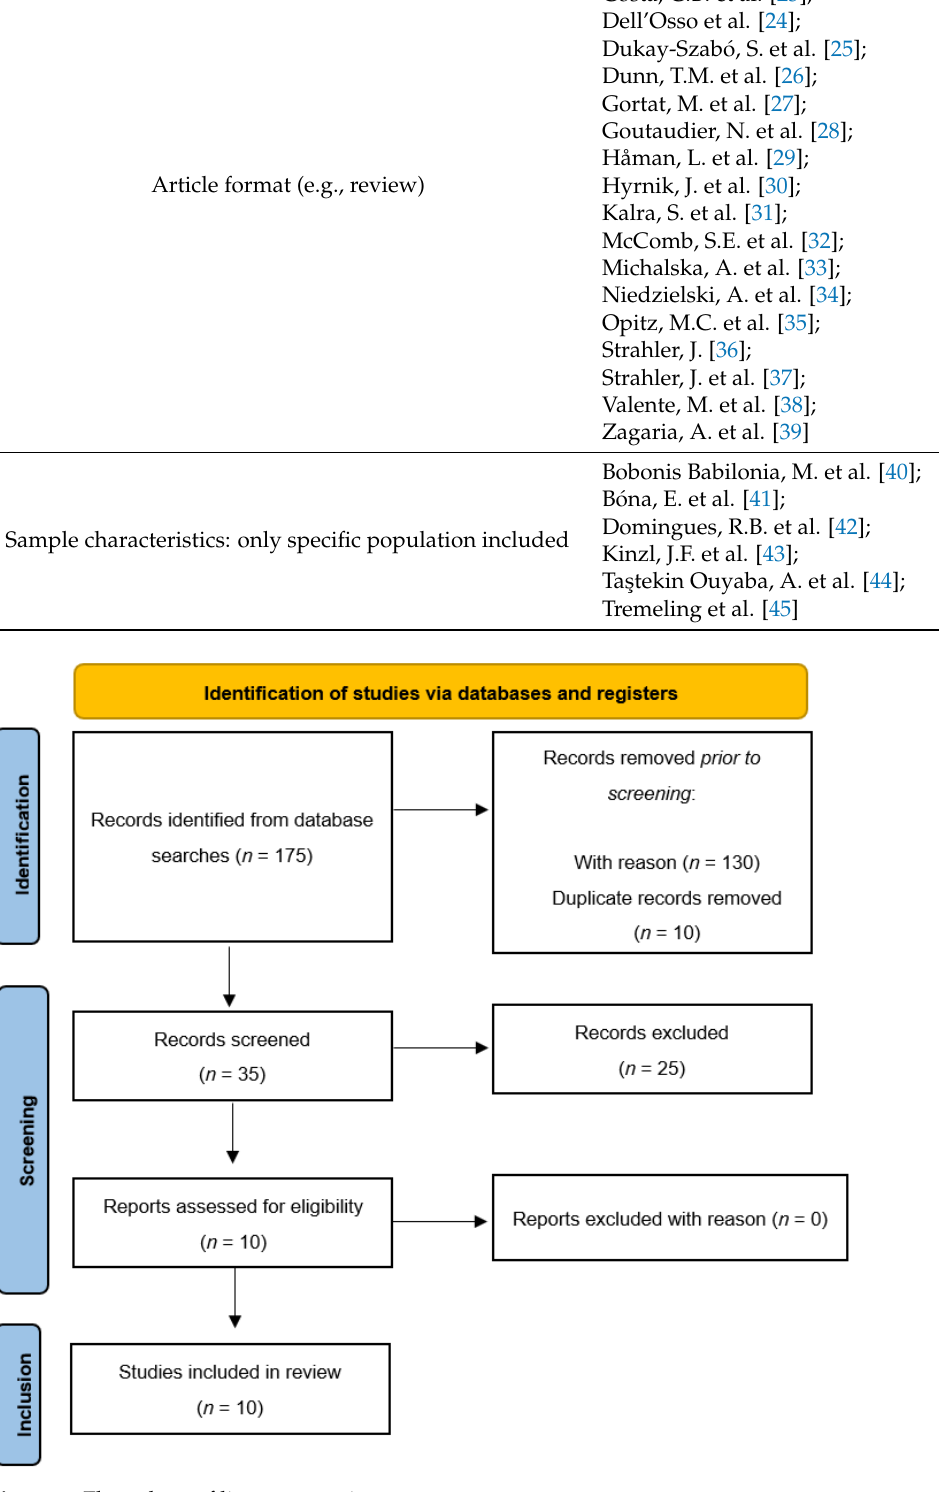
Figure 1. Flow chart of literature